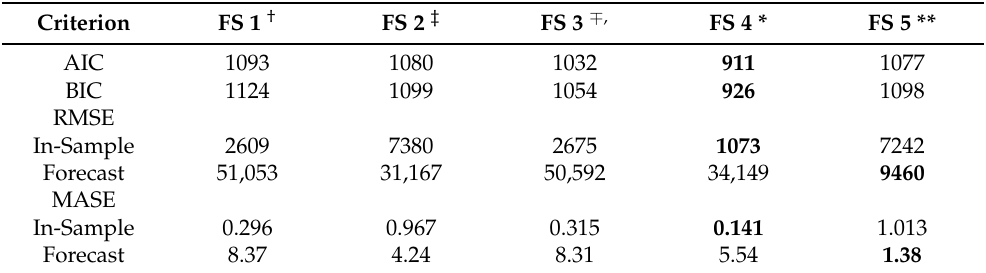
Table 3. Evaluation of exogenous feature sets using the baseline UCM. The addition of exogenous variables increases the performance of both the in-sample prediction and the forecast. The best forecast was obtained with the mixed Feature Set